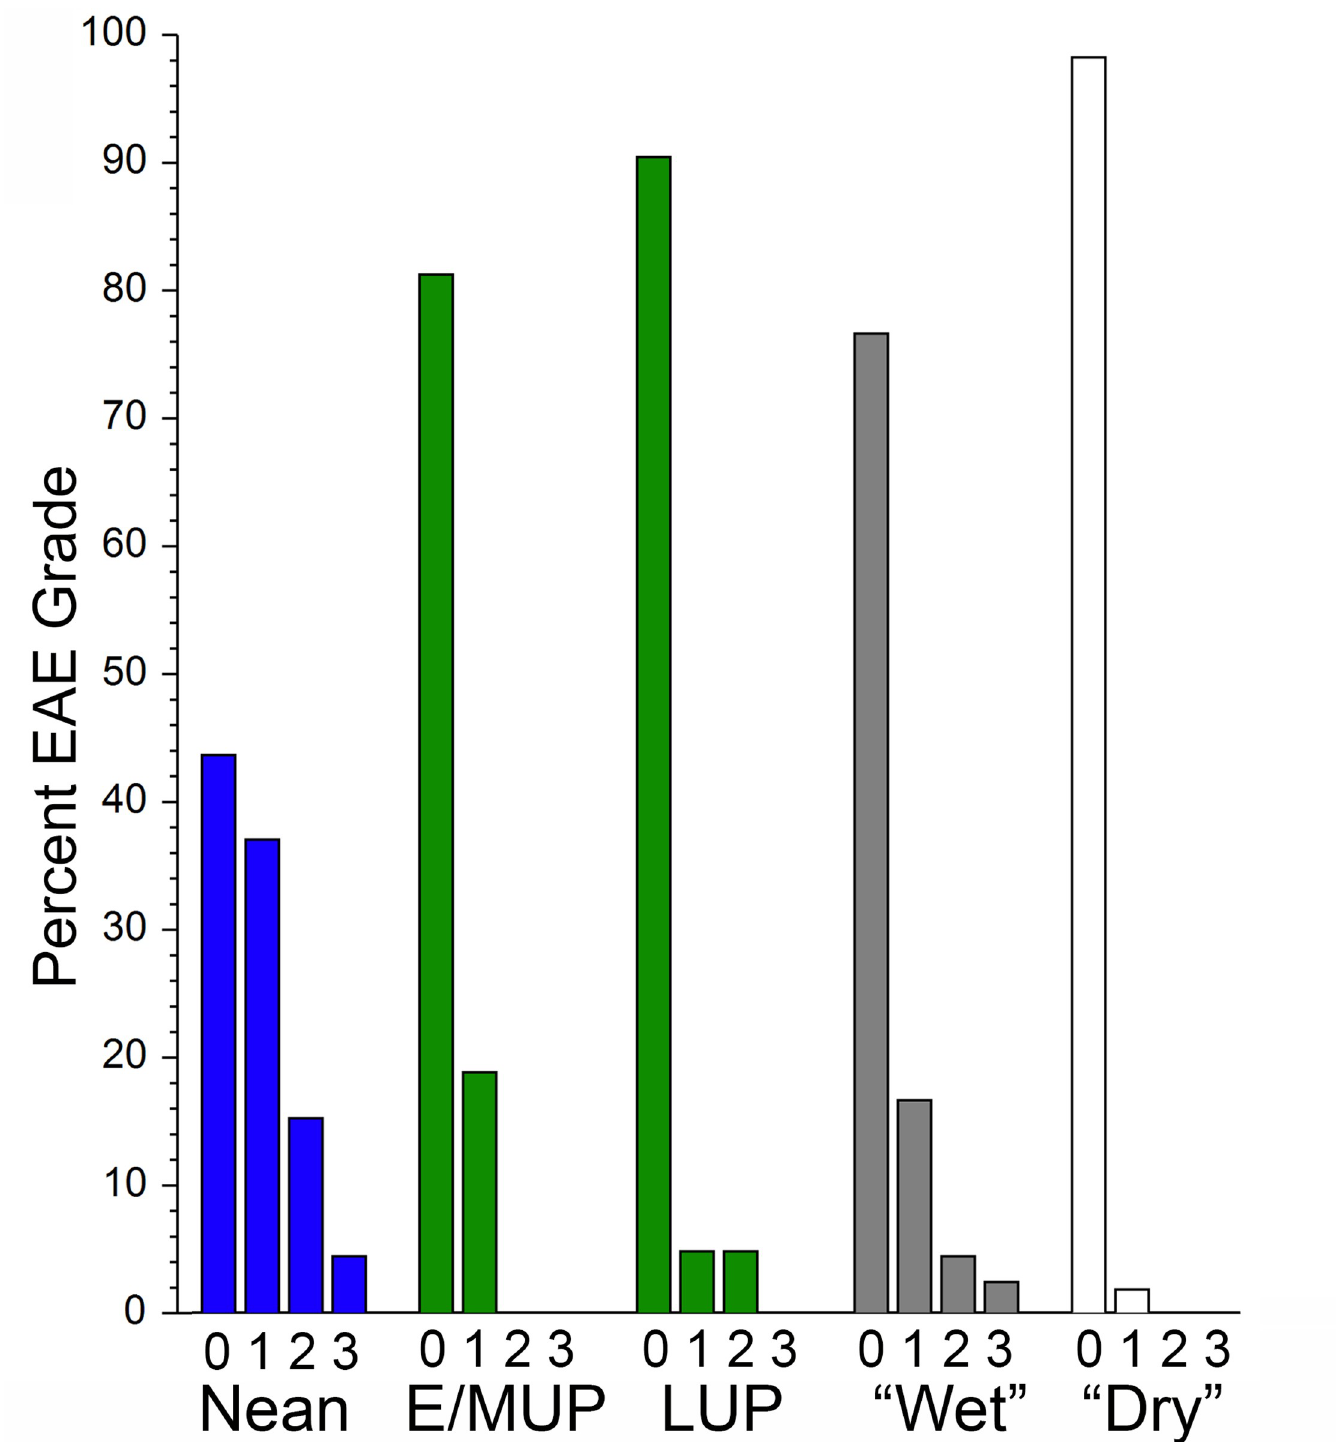
Fig 2. Distributions of external auditory exostosis (EAE) grades for samples of Neandertals, Early/Mid Upper Paleolithic modern humans (E/MUP), Late Upper Paleolithic modern humans (LUP), and coastal/riverine/lacustrine (“wet”) versus inland (“dry”) samples of recent humans. The paleontological data are in S1 Table, and the recent human data are in S3